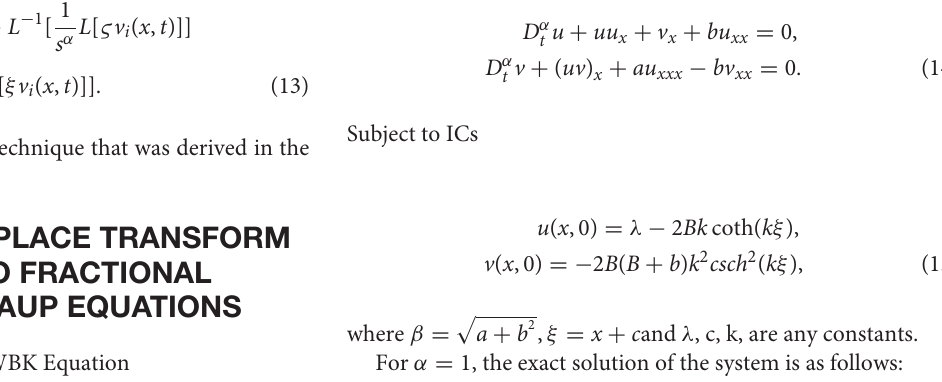
1 for ALW equation. =